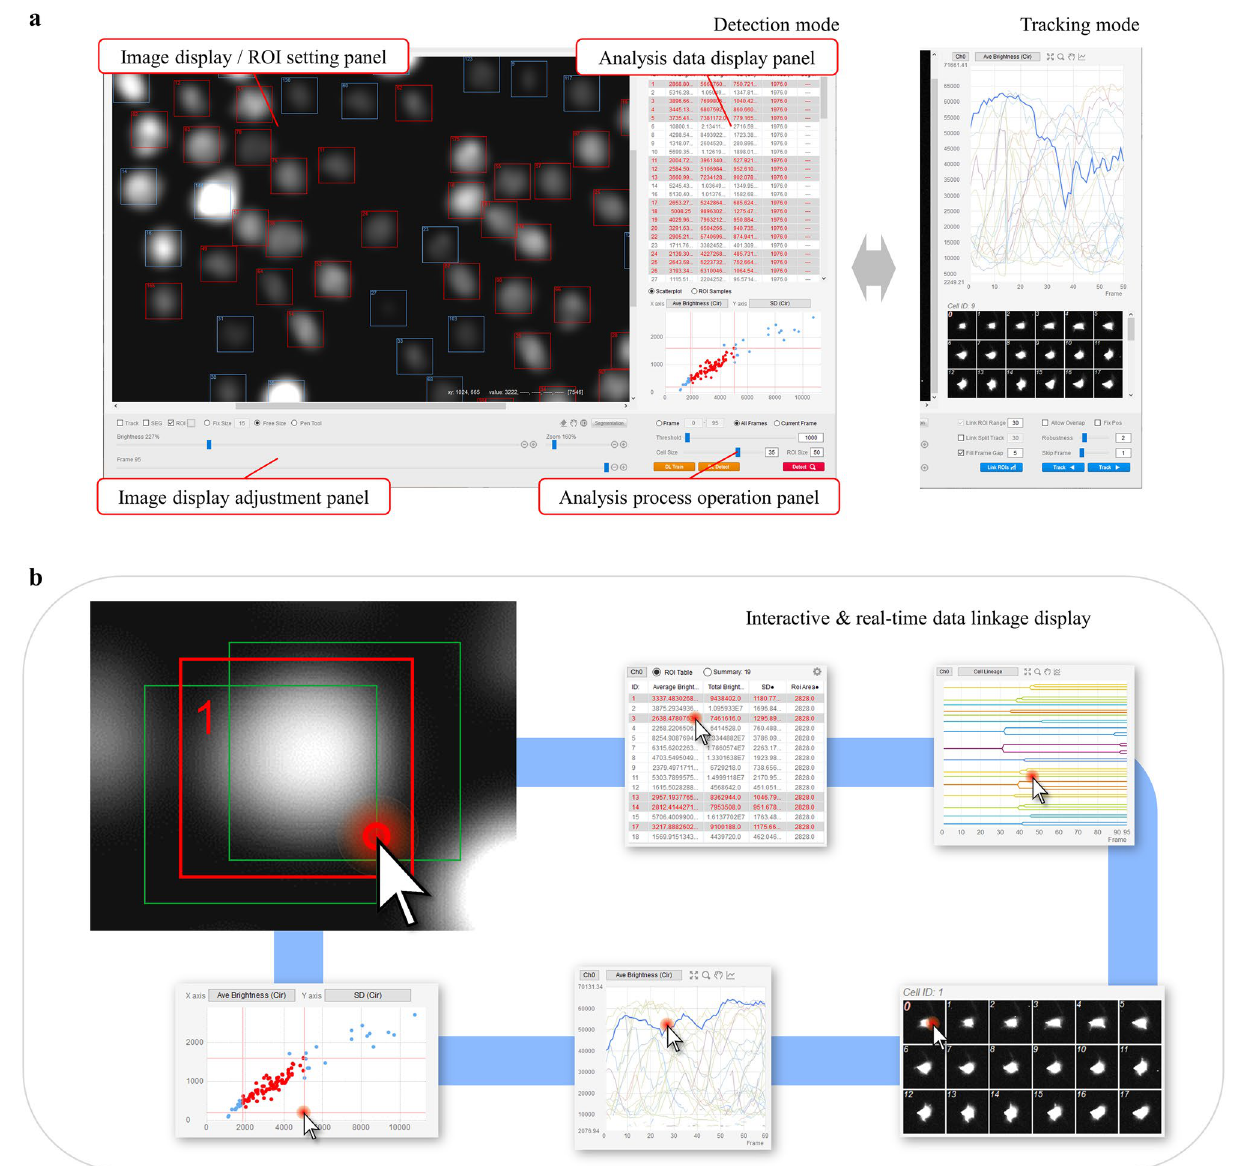
Figure 1. LIM Tracker screen structure. ( a ) LIM Tracker screen structure. The screen is divided into detection mode and tracking mode, and tracking is performed by switching between them. The entire screen is divided into four panels, with image display and ROI setting functions (top left), analysis data display functions (top right), image display adjustment functions (bottom left), and analysis processing operation functions (bottom right) integrated into each panel. ( b ) The ROI and each data display item (list, graph, scatter plot, montage image, cell lineage) are linked, and the display is updated in real time when there is a change in the ROI status. Each item in the data display responds to mouse clicks, and all data related to the selected item are instantly